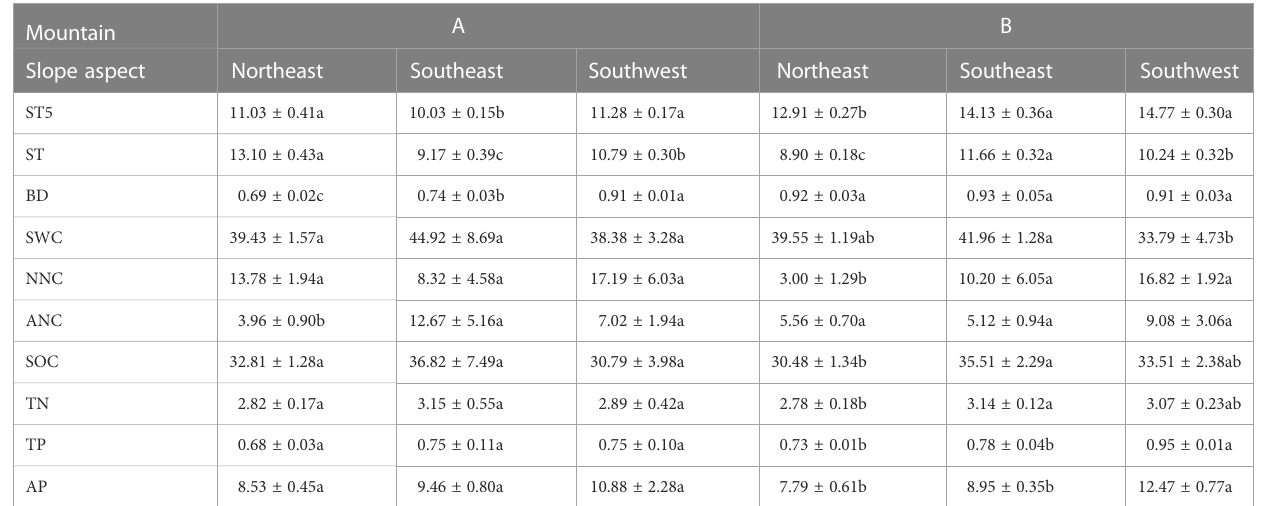
TABLE 1 The basic information about soil properties at two mountains.